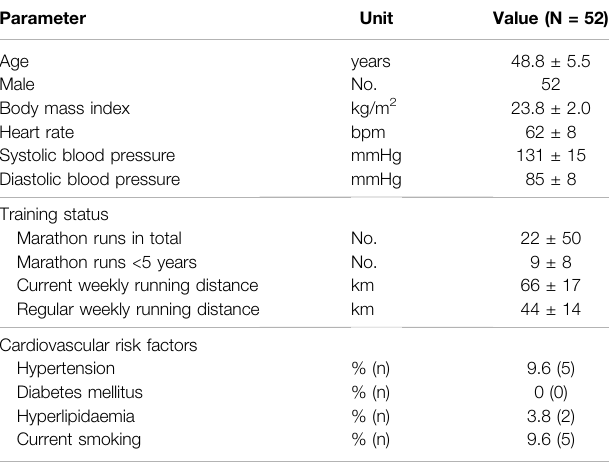
TABLE 1 | Study population. Parameter